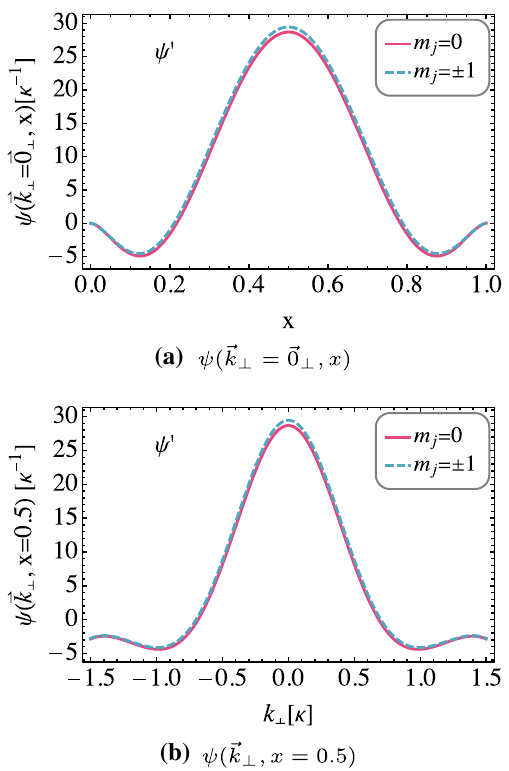
Fig. 9 Comparisons of different polarized states of ψ (cid:2) . The wavefunc- tionsaredefinedinEq.(51),withthebasisparameter κ = 1 . 34 GeVand m f = 1 . 27 GeV. a Dependence of the wavefunction on x at (cid:3) k ⊥ = (cid:3) 0 ⊥ , b dependence of the wavefunction on (cid:3) k ⊥ (θ k = 0 ,π) at x = 0 . 5 Table 6 The wavefunction of ψ( 3770 ) defined in Eq. (52). The values of basis coefficients are obtained by fitting the decay constant to the PDG value, at κ = ˆ κ, m f = ˆ m f . Uncertainties come from those of the Fig. 8 Plot of the ψ (cid:2) wavefunction according to Eq. (51) as a function parameters and those of the PDG decay constants. The percentage of of x and (cid:3) k ⊥ at θ k = 0 ,π , with the basis parameter κ = 1 . 34 GeV. a each basis state is calculated by taking the square of the corresponding ( (cid:3) k ⊥ , x ) , b ψ ( m j = 1 ) ( (cid:3) k ⊥ , x ) = ψ ( m j =− 1 ) ( (cid:3) k ⊥ , x ) ψ ( m j = 0 ) basis coefficient. The BLFQ values are extracted from the LFWF that ↑↓+↓↑ /ψ (cid:2) ↑↑ /ψ (cid:2) ↓↓ /ψ (cid:2) is solved from the Hamiltonian formalism [27]. The meson mass is estimatedbyevaluatingtheexpectationvalueof H accordingtoEq.(27) Value pct. (%) BLFQ